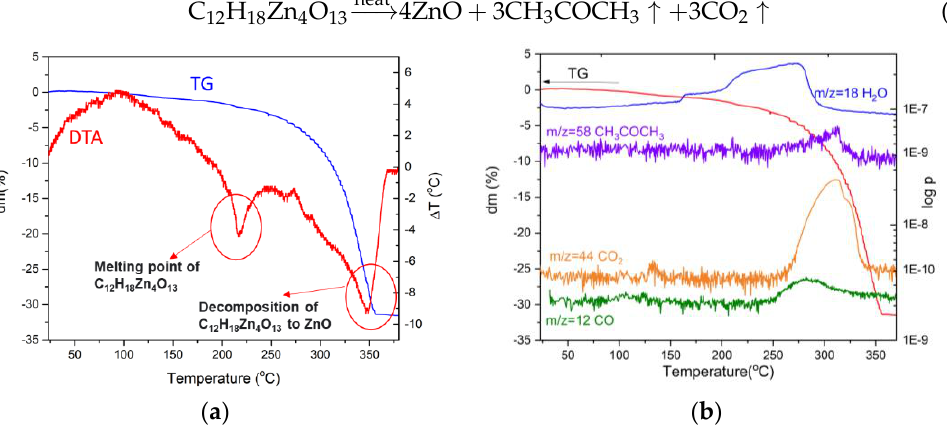
Figure 4 . Thermal stability of the coated fibres investigated via DTA-TG-MS. ( a ) DTA-TG, ( b ) TG-